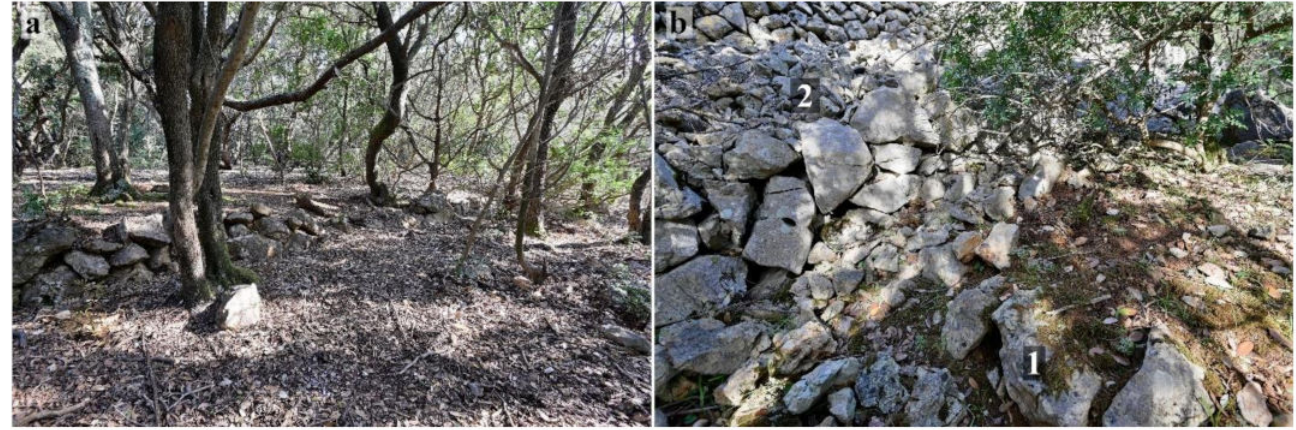
Figure 23. ( a ) Terrace riser running along the slope ( b ) Terrace riser (1) covered by a massive stone clearance deposit (2). (Photos: M. Doneus, 13 April 2022).